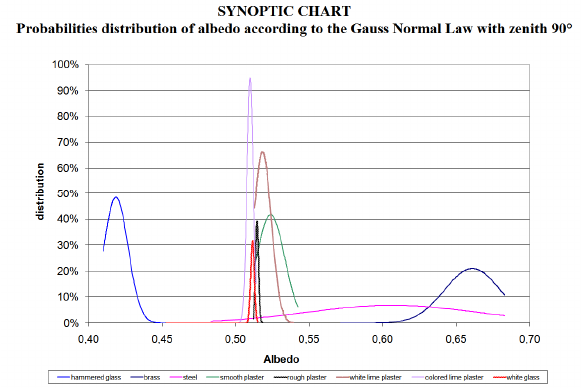
Figure 9 - Gaussian distribution of the albedo data for the various materials